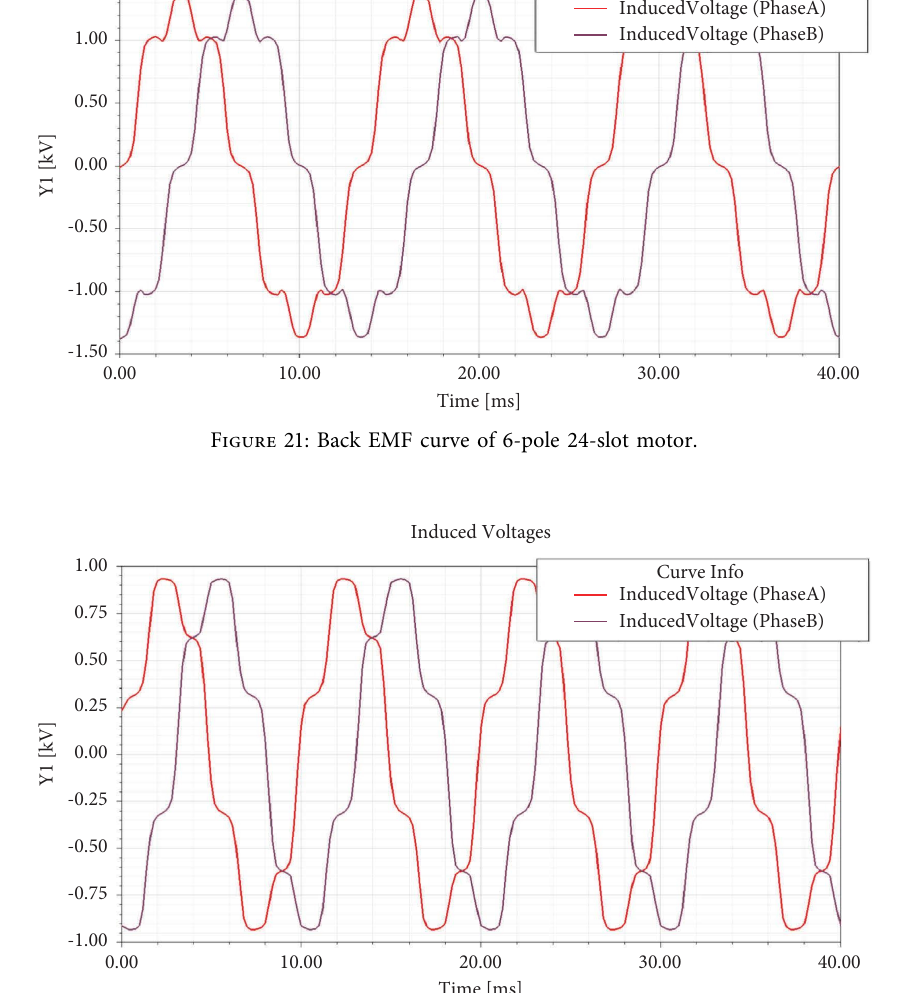
Figure 22: Back EMF curve of 8-pole 24-slot motor.